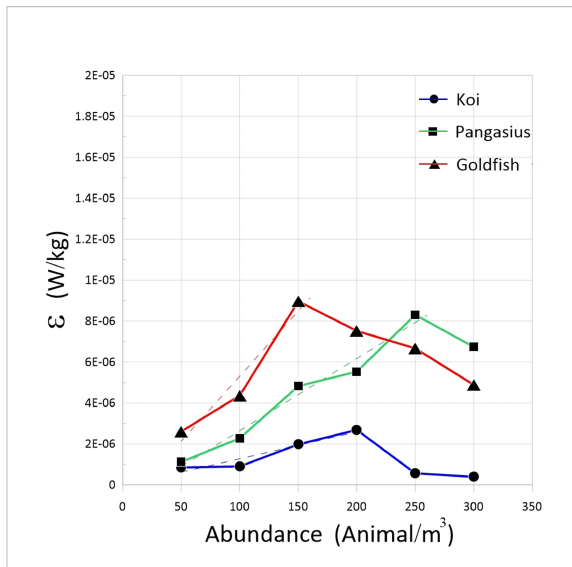
Table 3. The integral time scale of the fl ow generally increased as